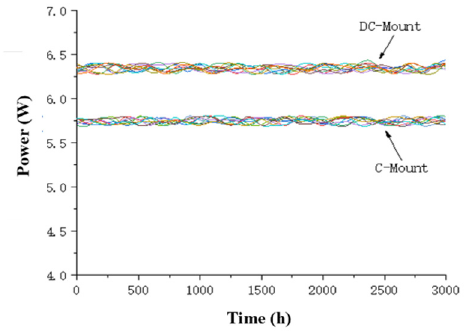
Figure 10. Life test curve comparison.